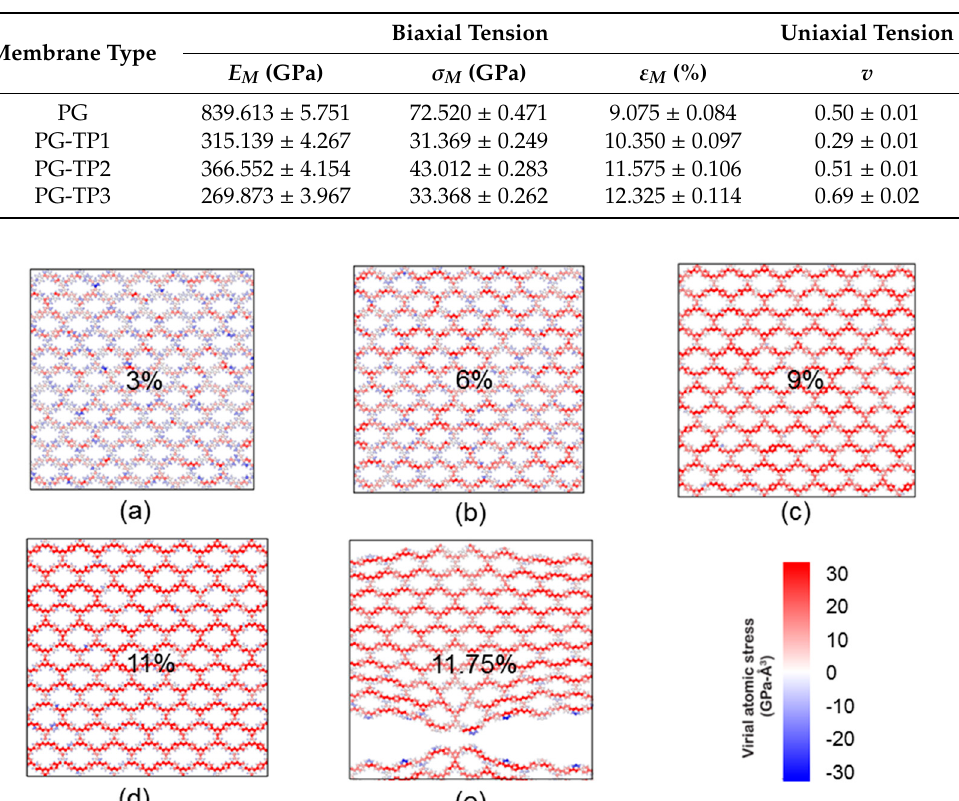
Figure 4. Stress distribution in PG-TP2 sheet with increasing biaxial stress. The stress at each atom is represented by its color with red regions corresponding to the areas of highest stress (see the color bar). The strain in the figure is ( a ) 3%, ( b ) 6%, ( c ) 9%, ( d ) 11%, and ( e ) 11.75%.